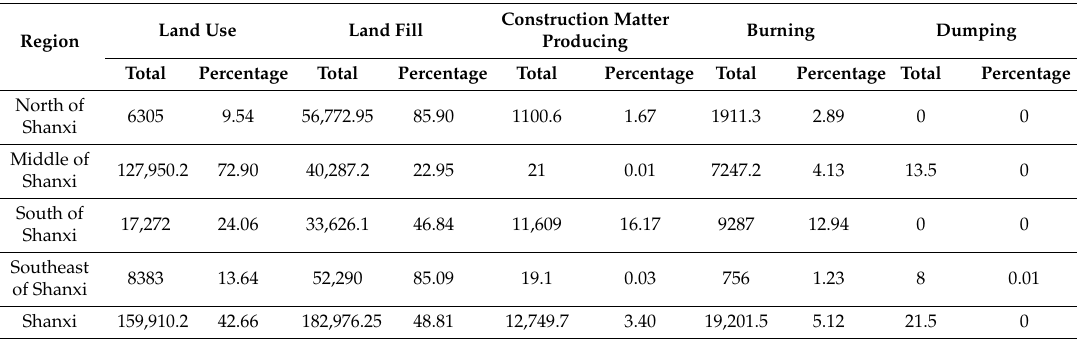
Table 1. Disposal situation of sewage sludge in Shanxi in 2011 1 .